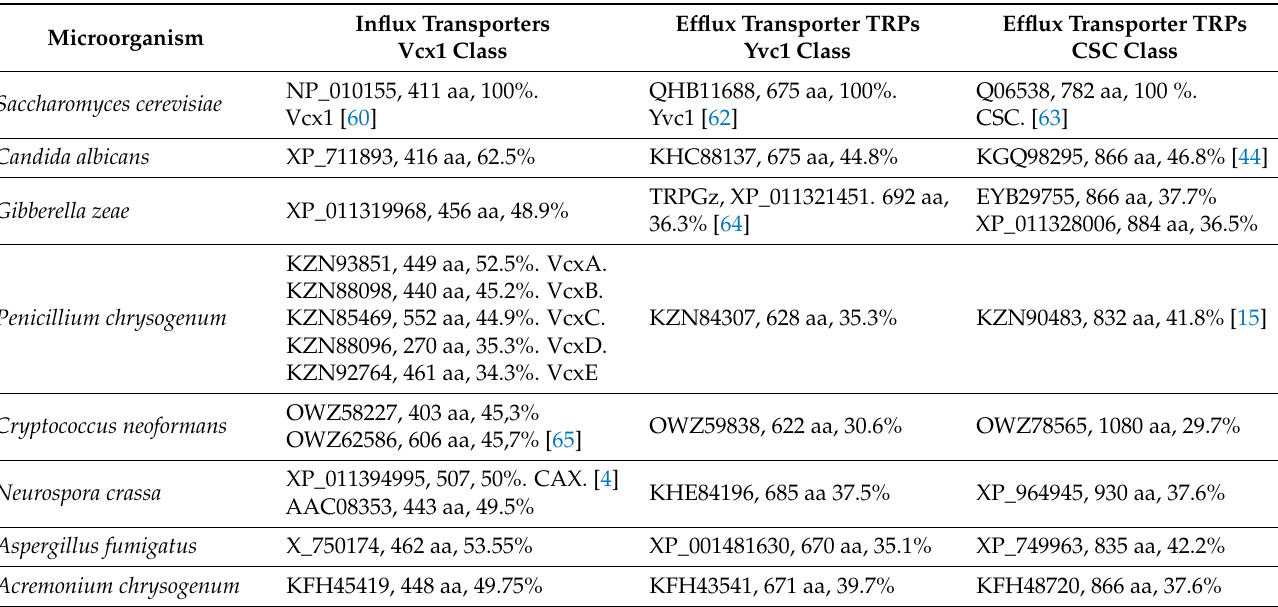
Table 1. Well-characterized classes of calcium transporters and TRPs in yeast and filamentous fungi in comparison to S. cerevisiae proteins 1,2